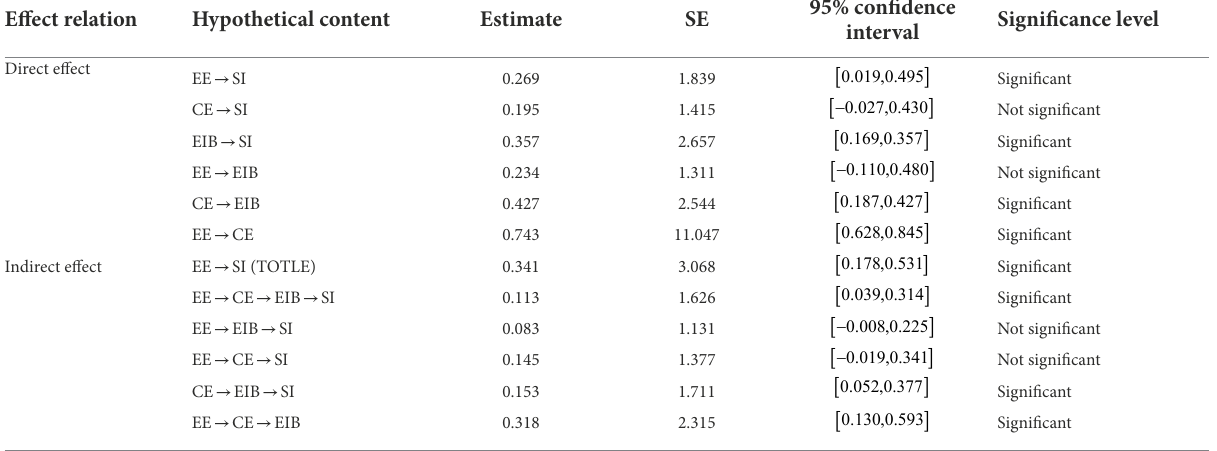
TABLE 4 Analysis of hypothesis test